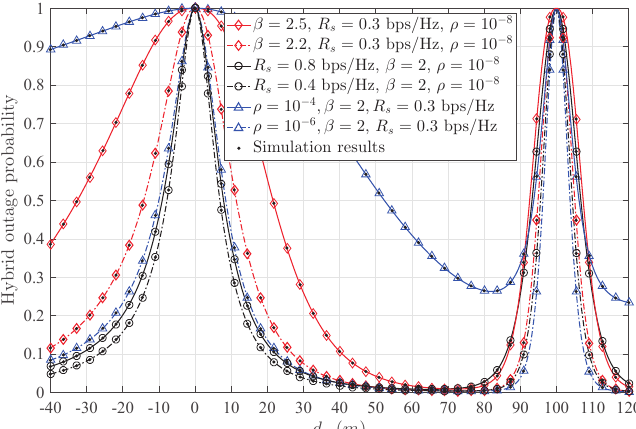
Figure 10. The influence of R s , β , and ρ on the hybrid outage probability P act